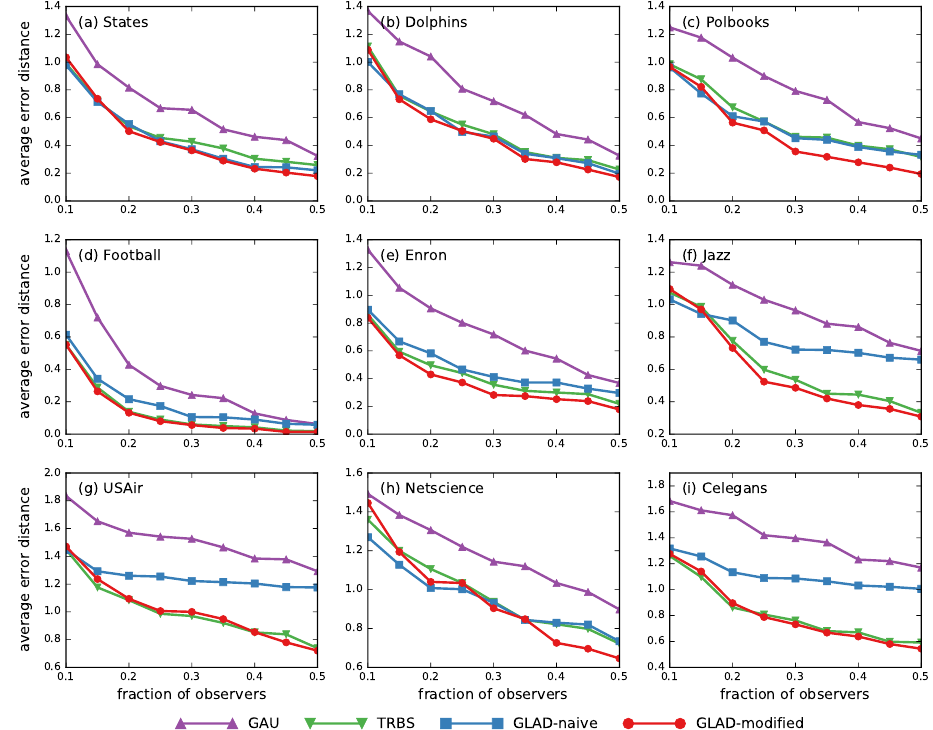
Figure 9. Average distance between the estimated source and the real source by source localization algorithms on nine real networks with signal-to-noise ratio µ / σ = 4. If more than one node is ranked first, we randomly choose one as the estimated